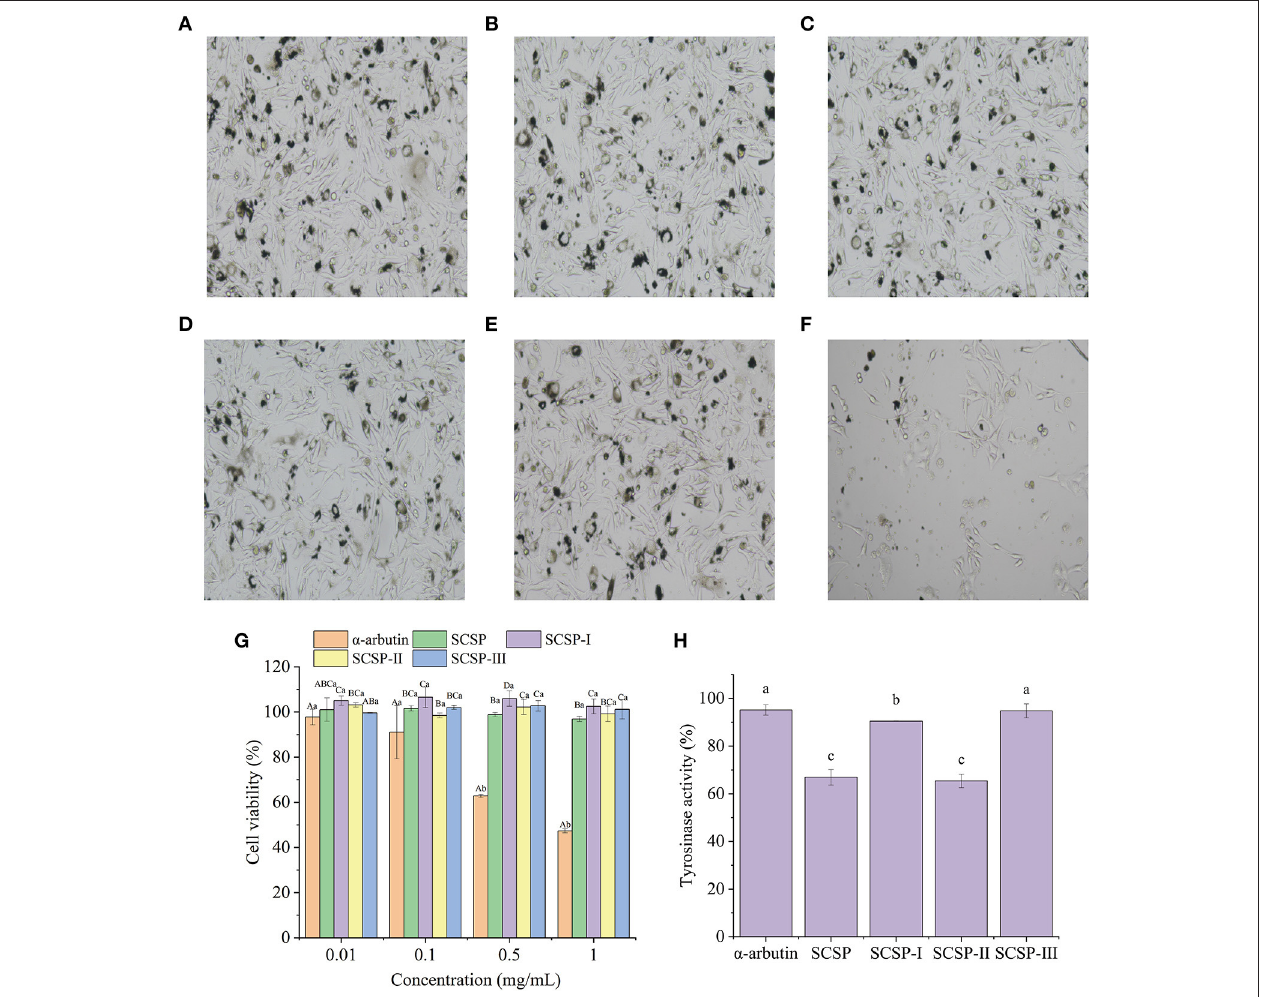
FIGURE 3 | Morphology of mouse B16 melanoma cells in the normal state (blank control) (A) , and under the action of 1.0 mg/mL SCSP (B) , SCSP-I (C) , SCSP-II (D) , SCSP-III (E) , and α -arbutin (F) . The proliferative activity (G) of mouse B16 melanoma cells under the action of SCSPs at 0.01, 0.1, 0.5, 1.0 mg/mL, respectively. The cell tyrosinase activity (H) under the action of 0.01 mg/mL SCSPs. In (G) , different capital letters denote significant differences between the SCSP, SCSP-I, SCSP-II, and SCSP-III groups at the same concentration ( P < 0.05), and different lowercase letters denote significant differences between the same fractions of different concentrations ( P < 0.05). In (H) , different lowercase letters denote significant differences between groups ( P < 0.05). All experiments were repeated three times. Data are expressed as mean ± standard